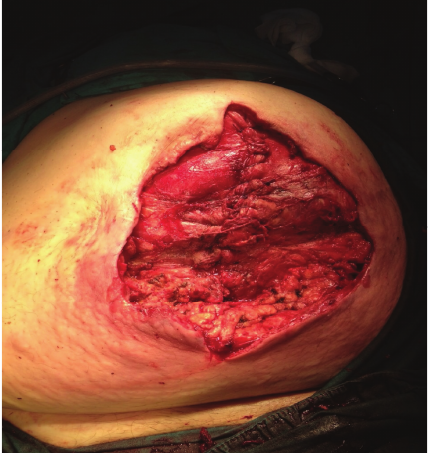
Figure 3: Postoperative photo of the wound.